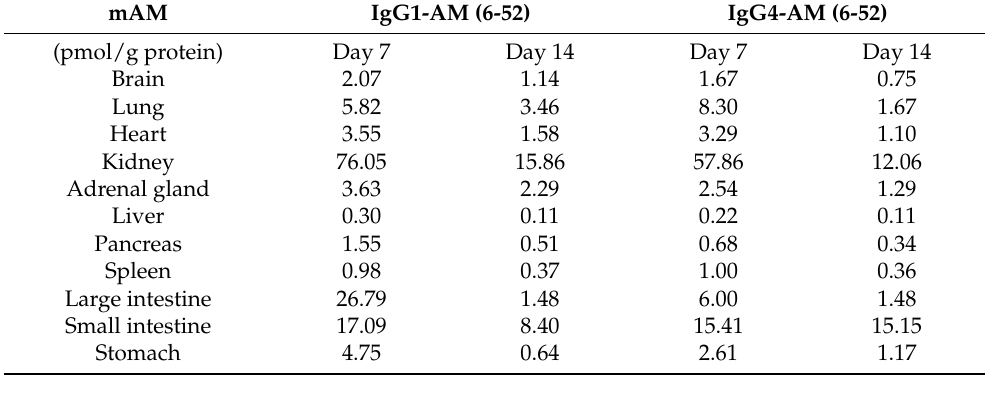
Table 3. The tissue levels of mAM were determined by enzyme immunoassay.